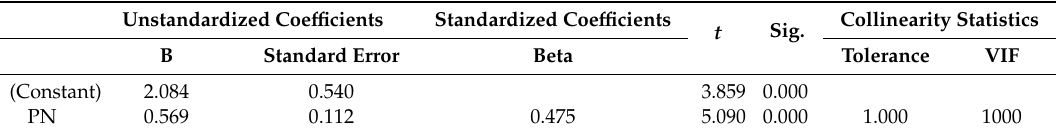
Table 16. Final results of the statistical significance